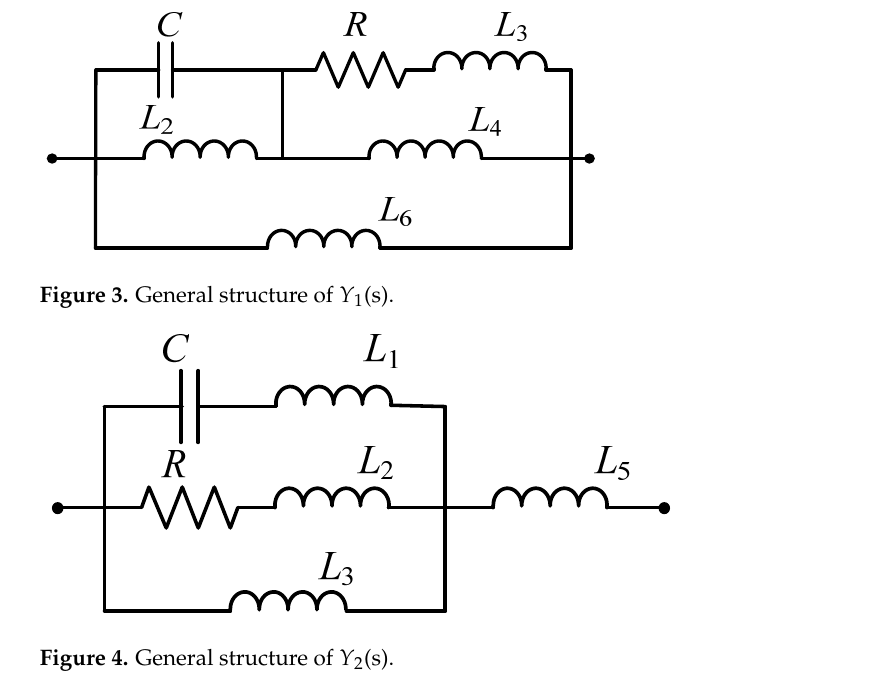
Figure 4. General structure of Y 2 (s).